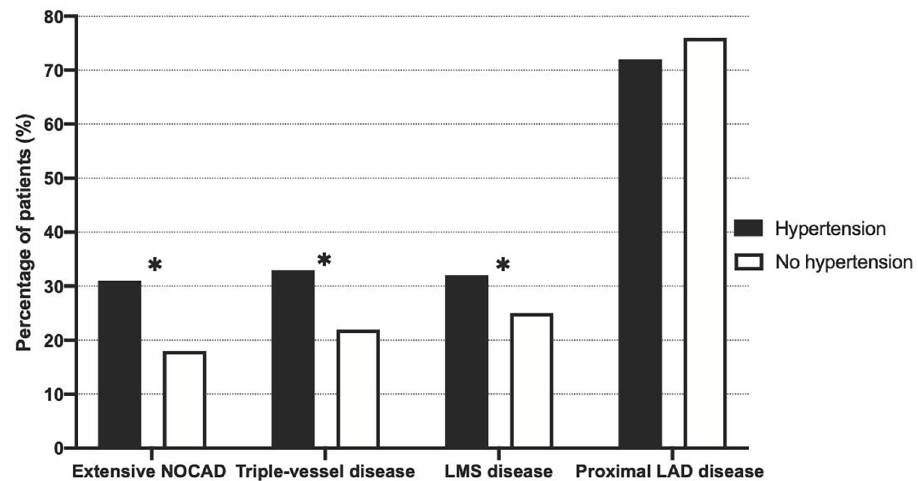
Fig 1. Non-obstructive coronary artery disease characteristics in patients with and without hypertension. NOCAD: non-obstructive coronary artery disease, LMS: left main stem, LAD: left anterior descending. � p < 0.05 between groups.